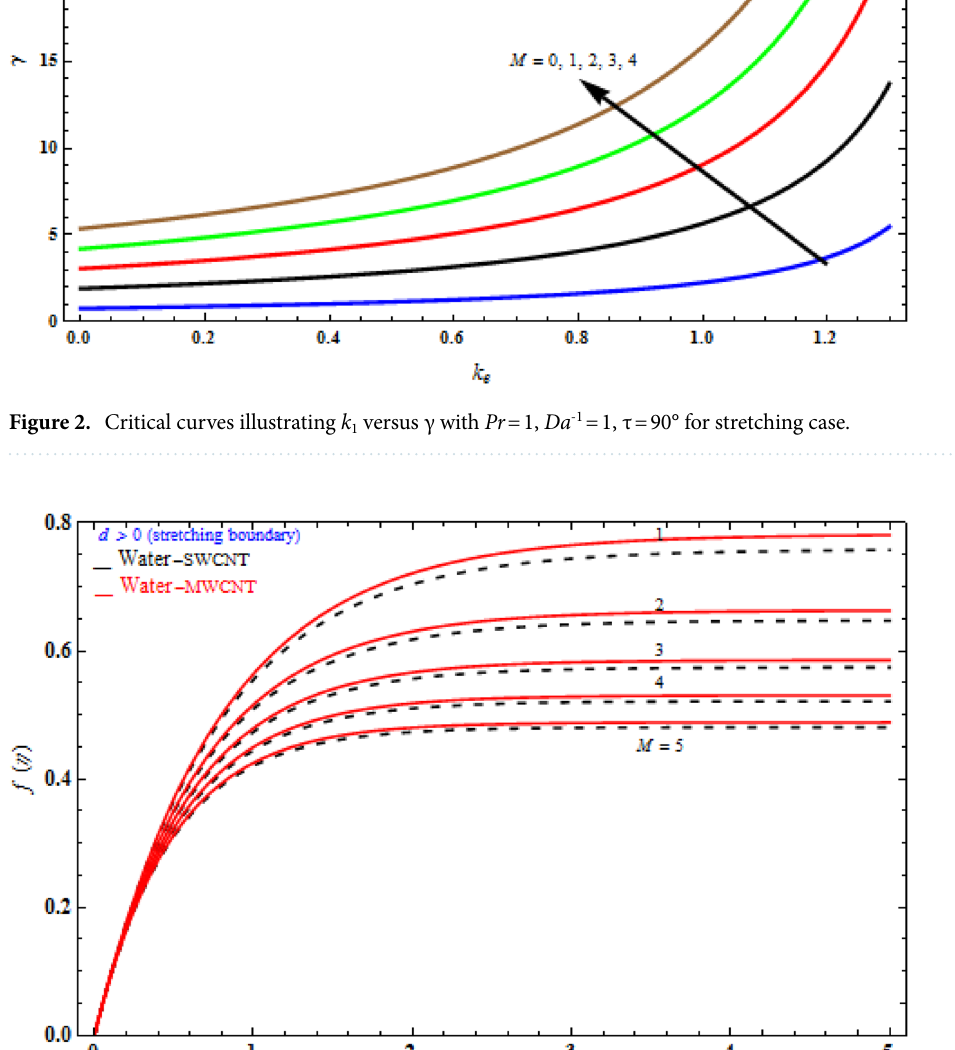
Figure 3 signifies the depiction of Darcy model Da -1 on f (η) while the stretching sheet is more than zero. The f (η) of MWCNT is more than that of SWCNT. The f (η) enhances as the Darcy number also increases. The magnetic field’s inclined parameter is 90 degree. Figure 4 portrays the various values of magnetic parameter M on f (η) with deference to the similarity variable η at the point when the stretching boundary layer is more than nothing. As seen in the diagram, the Lorentz effect is reduced when the raising the M decrease the thickness of the boundary layer, resulting in increased shear stress on the wall. The reason for this is because when the mag- netic parameter rise, the boundary layer increases, which is accompanied by a increase in the velocity gradient. In addition, the volume fraction is enhances, the boundary layer thickness enhances. Figure 5 portrays the various values of viscoelastic k 1 on transverse velocity f (η) regarding the similarity vari- able η at the point when the stretching boundary layer is bigger than nothing. The viscoelastic constraint raises the extent of the boundary layer enhances in the stretching surface. The transverse velocity which occurs where